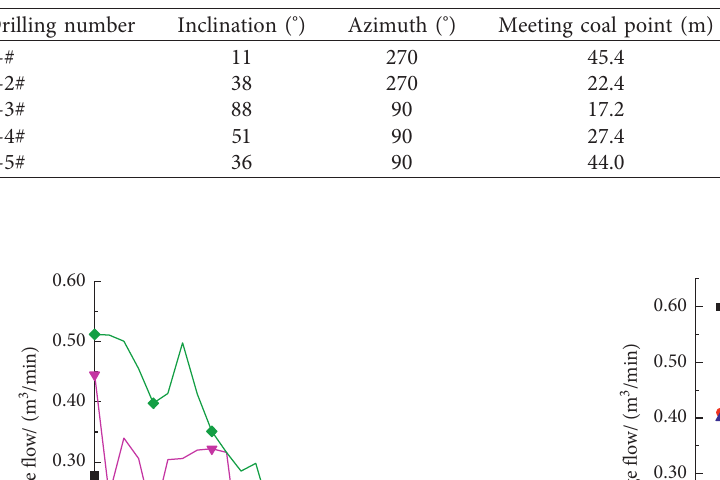
Table 1: Borehole design